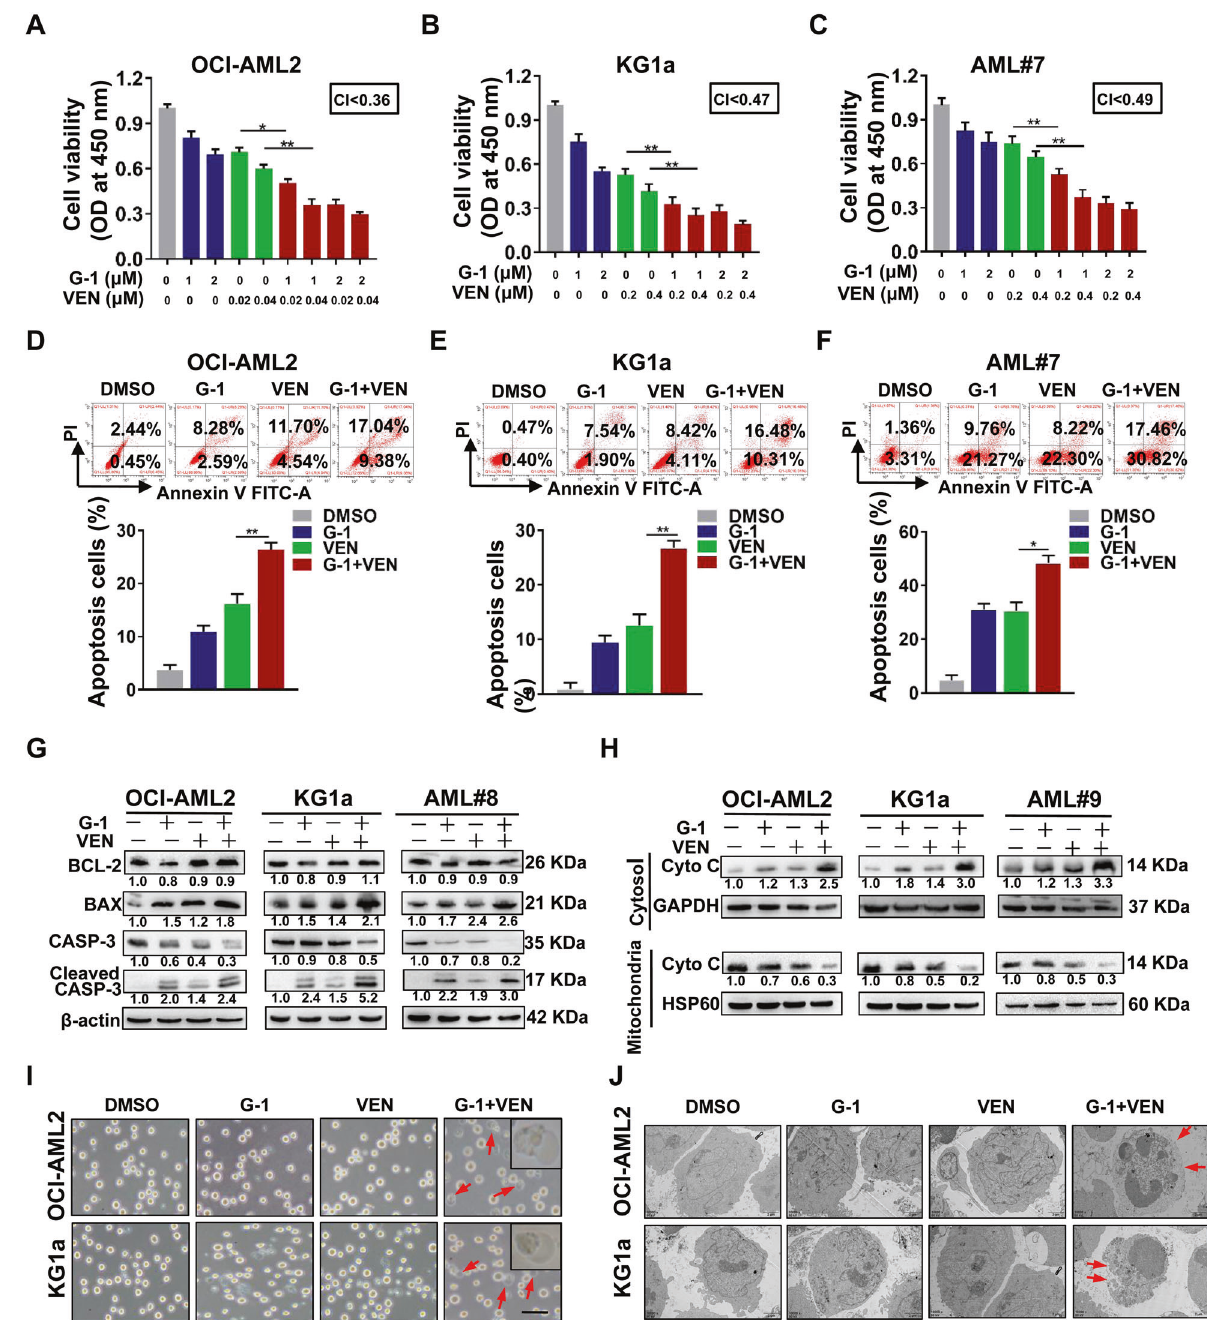
Fig. 3 GPER agonist G-1 and venetoclax synergistically inhibit leukemic cell survival through apoptosis and pyroptosis. A – C CCK-8 assay of cell viability in the cell lines and primary blasts treated with G-1 and VEN, alone or in combination for 48 h, CI values were calculated using CompuSyn software. D – F FCM of apoptosis in the cell lines, primary blasts treated with G-1 (1 μ M) and VEN (OCI-AML2; 0.02 μ M, KG1a; 0.2 μ M, AML#7; 0.2 μ M), alone or in combination for 24 h. G Western blotting of these apoptosis related proteins. H Western blotting of Cyto C in the mitochondria fractions and cytosolic fraction of the cells treated with indicated drugs for 24 h. I Representative light microscopy images of the same treated cells as in Fig. 3D, E. The red arrowheads indicated the characteristic balloons on the cell membrane (Scale bar: 50 μ m). J Representative transmission electronic micrographs of the leukemic cells (Scale bar: 2 μ m). The data are expressed as the mean ± SD ( n = 3). * p < 0.05, ** p < 0.01, *** p <